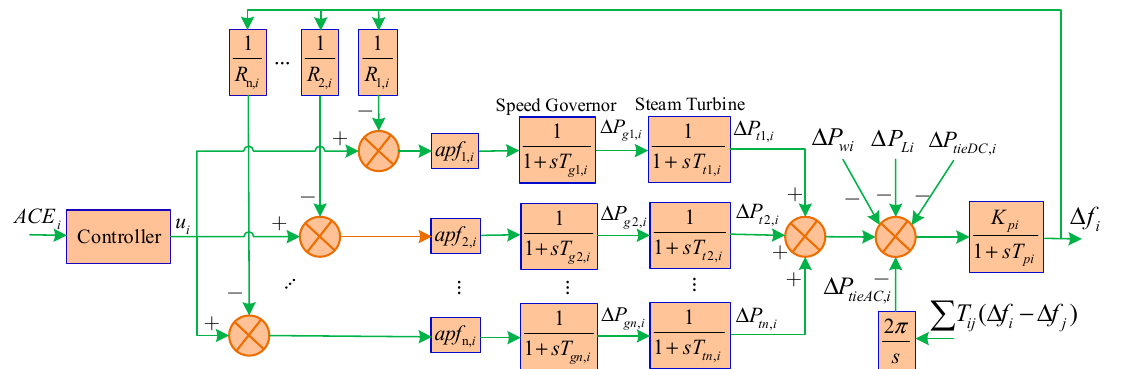
Figure 1. Diagram of automatic generation control (AGC) model for control area i with wind farm. ACE, area control error. Table 1. Meanings of symbols of state space variables